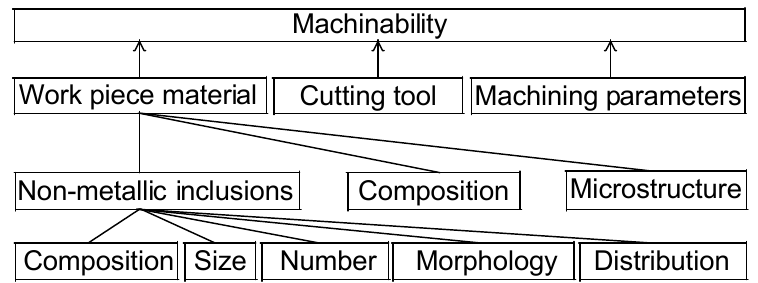
Figure 3. A schematic illustration of how machinability is connected to underlying factors and parameters including properties of work pieces, cutting tools and the machining conditions.